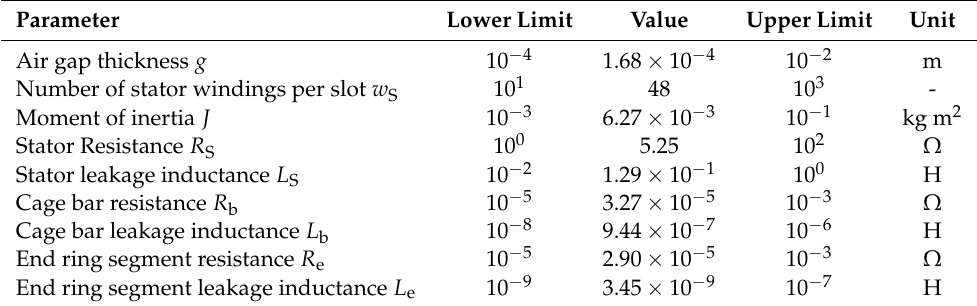
Table 3. Required parameters for the modeling of the examined induction motor with lower and upper limit of the search space (source of limits: power of considered machine) as well as the value identified via the differential evolution